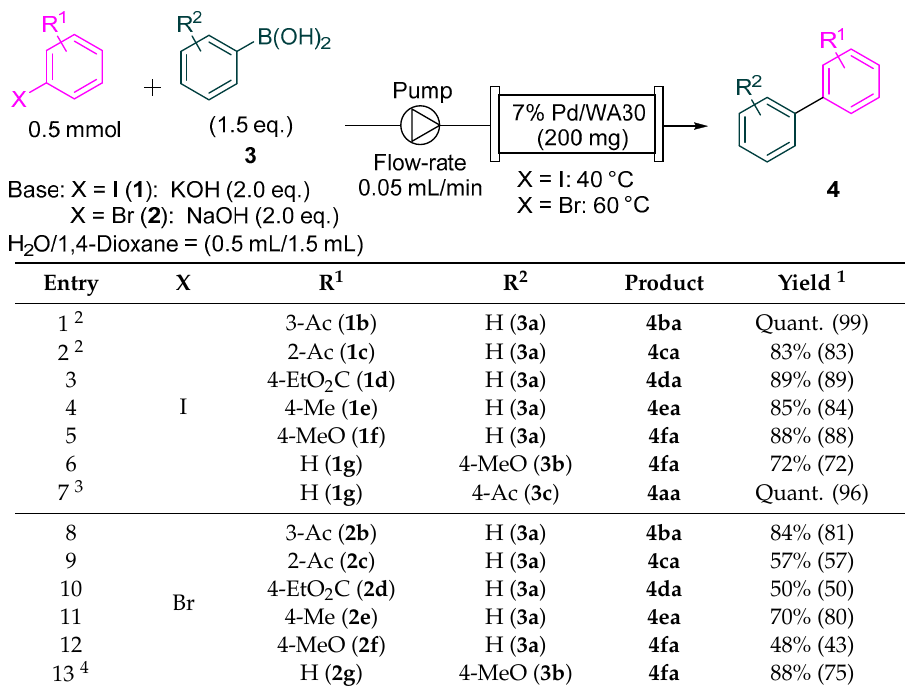
Table 2. Scope of substrate for the 7% Pd/WA30-catalyzed continuous-flow Suzuki–Miyaura coupling reaction of 4’-iodo and 4’-bromobenzene derivatives ( 1 or 2 ) with aryl boronic acid ( 3 ). a.